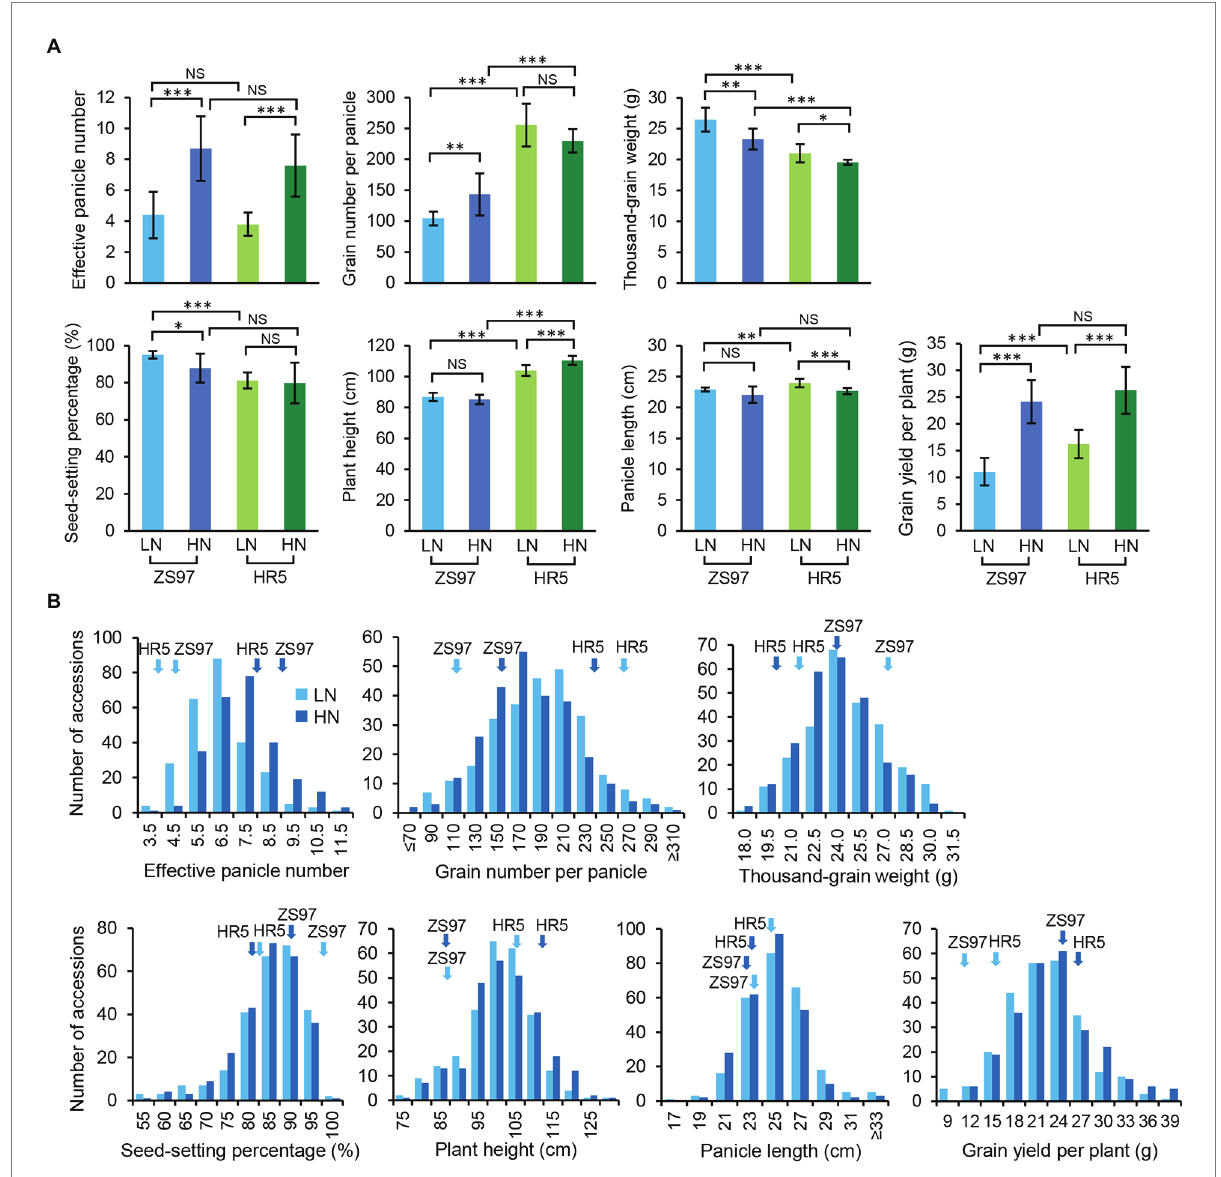
FIGURE 1 Performance of the agronomic traits of the parents (A) and RIL population (B) under two N levels. LN, low nitrogen; HN, high nitrogen. *** p < 0.001, ** p < 0.01, * p < 0.05; NS, not significant. The light and dark blue, respectively, indicate LN and HN conditions. The performances of the parents are marked by